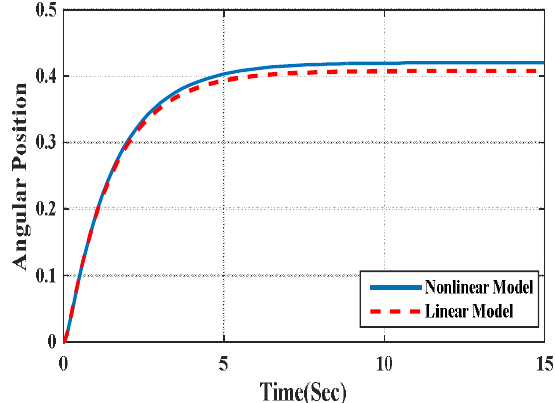
Fig. 3. Time response for linear and nonlinear model with velocity feedback gain k v = 3.74